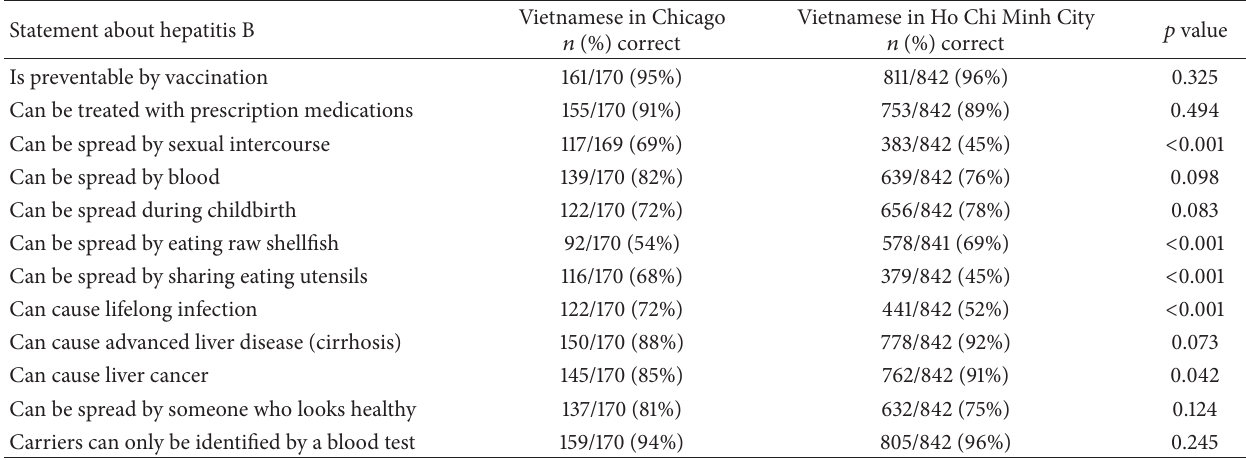
Table 2: Hepatitis B knowledge. Participants were asked to indicate whether the following statements about hepatitis B are true or false. Statement about hepatitis